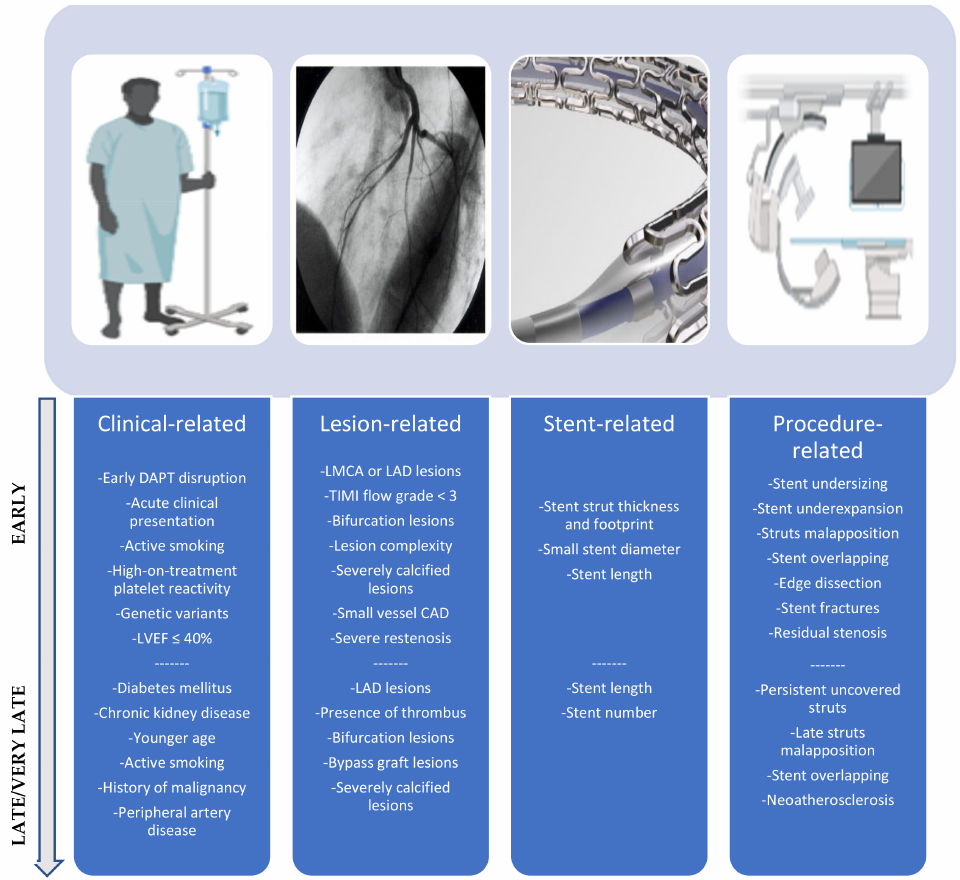
Figure 1. Overview of the main factors associated with stent